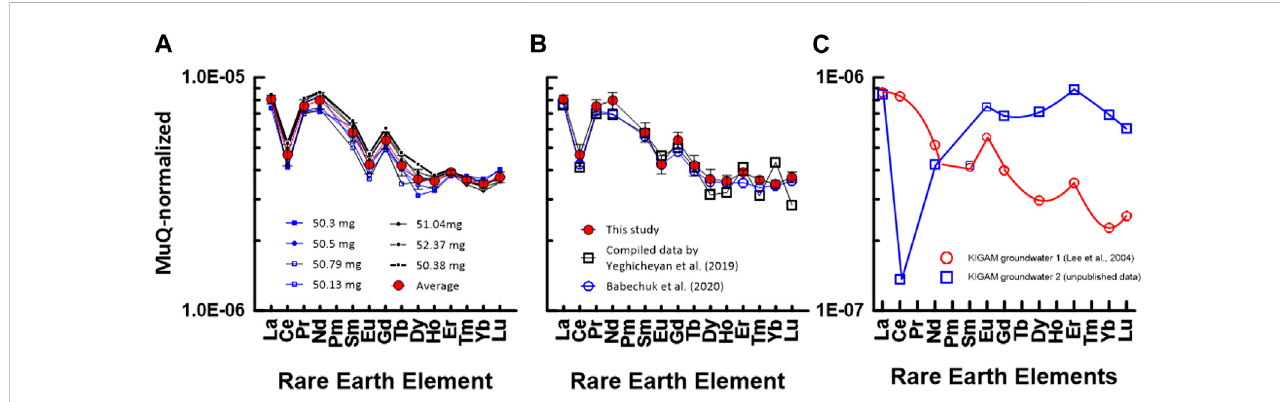
FIGURE 3 MuQ(Kamberetal.,2005)-normalizedREEpatternsofSLRS-6: (A) inthisstudyand (B) fromdatabyBabechuketal.(2020)andYeghicheyan etal.(2019). The numbers in (A) indicate the gravity weight of ca. 50 mL of SLRS-6 used for preconcentration. (C) MuQ-normalized REE patterns of KIGAM groundwaters. REE concentrations in groundwater were measured by ID-TIMS method using a JEOL JMS 05-RB TIMS (Lee et al.,